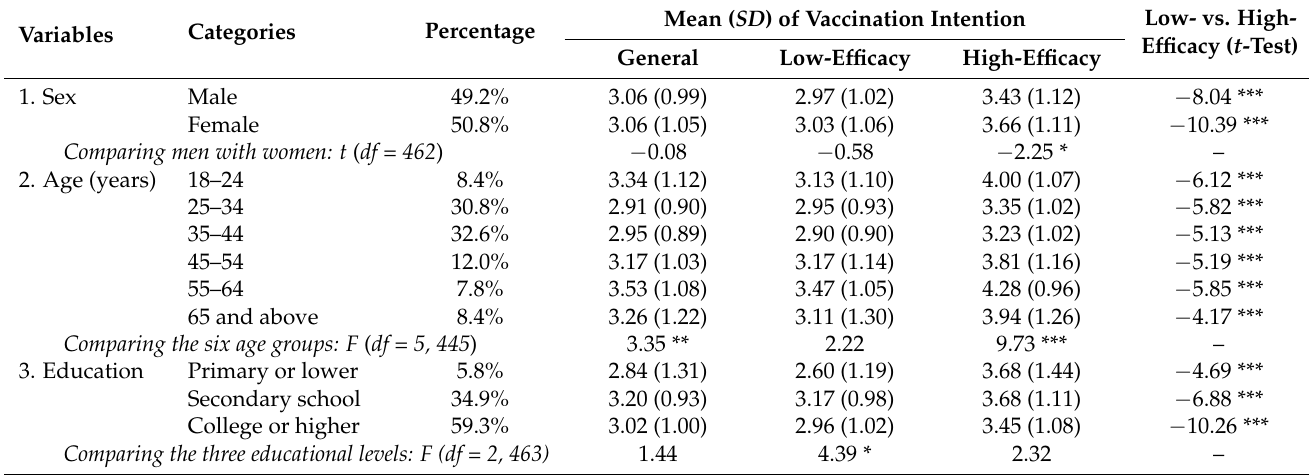
Table 1. The effect of demographic variables on vaccination